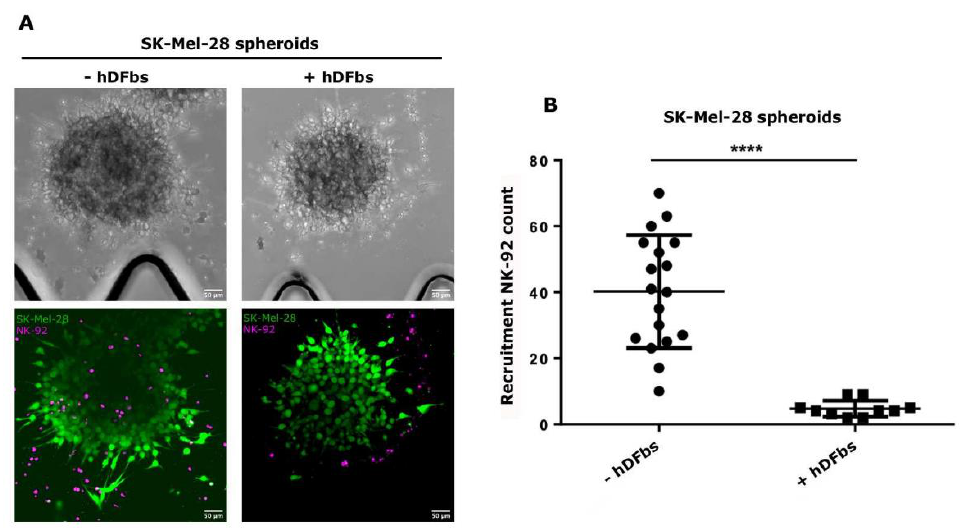
Figure 2. NK-92 migration: ( A ) Representative confocal images of recruitment inhibition. Magnifi- cation, 20×. Scale bar, 50 μ m. On the left, monoculture of SK-Mel-28 spheroids in bright fields (on the top) and fluorescence (on the bottom; green, calcein). On the right, co-culture of SK-Mel-28 and hDFbs spheroids in bright fields (on the top) and fluorescence (on the bottom; green, calcein). In both fluorescent images, NK-92 were labeled with a fluorescent cell tracker (em. 647). ( B ) Plot shows the analysis of the recruitment inhibition of NK-92, significantly higher when hDFbs were added in the culture ( “****” p < 0.005, unpaired t- test with Welch’s correction) (SK -Mel-28, n = 18; SK-Mel-28 + hDFbs, n = 10).